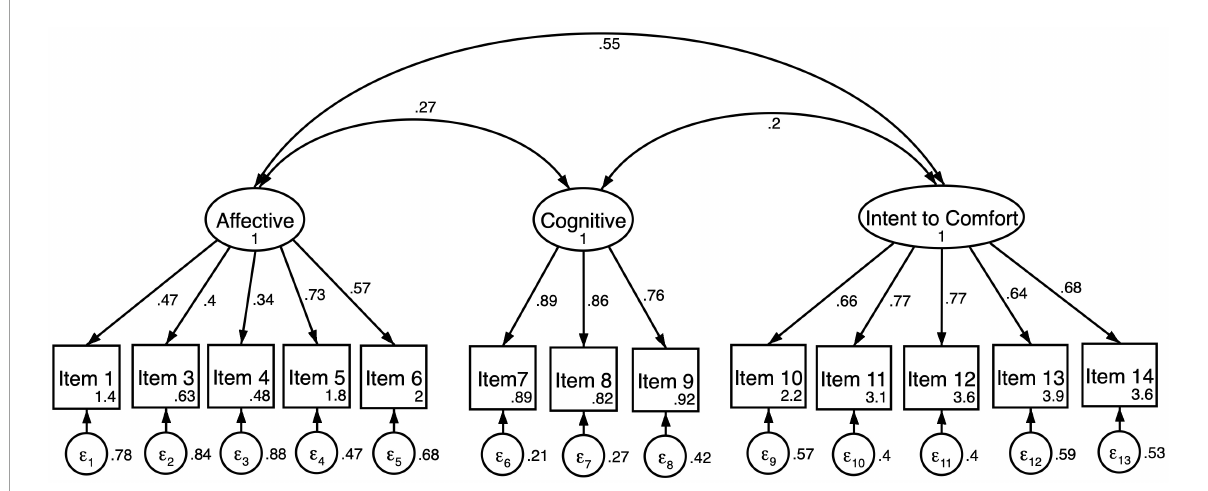
FIGURE2 Three-factor confirmatory factory analysis of the EmQue-CA (13 items) for boys ( N = 128). All factor loadings on latent factors significant at the p < 0.001 level. Values inside item boxes represent intercepts.